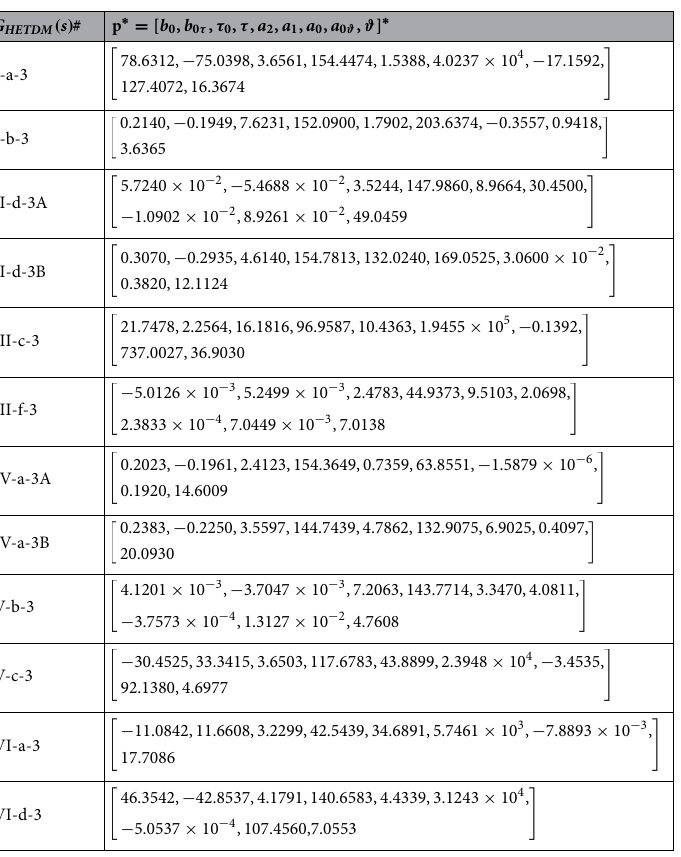
Table 11. HETDM transfer function parameters computed via the NM method (artificial delays are used).